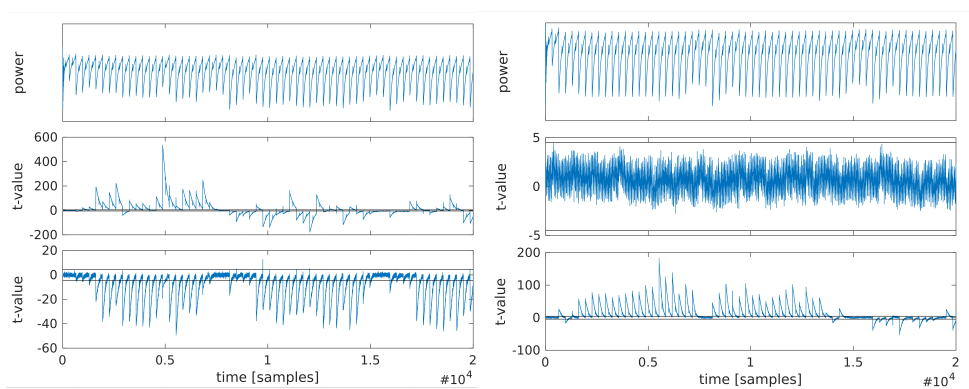
Figure 8: Non-specific leakage detection test on 2.5 rounds of encryption of a first-order protected AES. Left: PRNG off; 12 000 traces. Right: PRNG on; 50 million traces. Rows(top to bottom): exemplary power trace, first-order, second-order t-value.